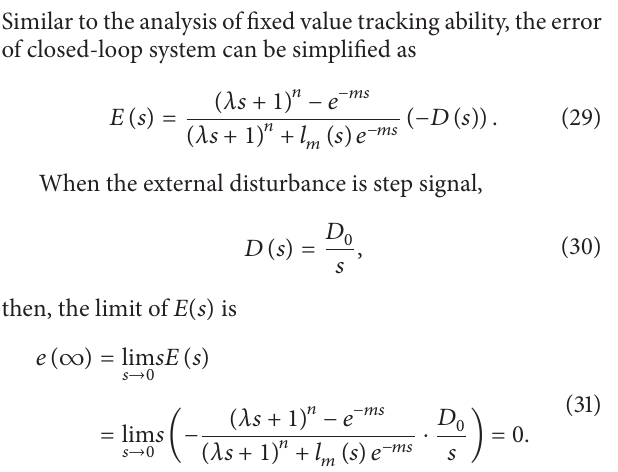
Figure 5: SIM control